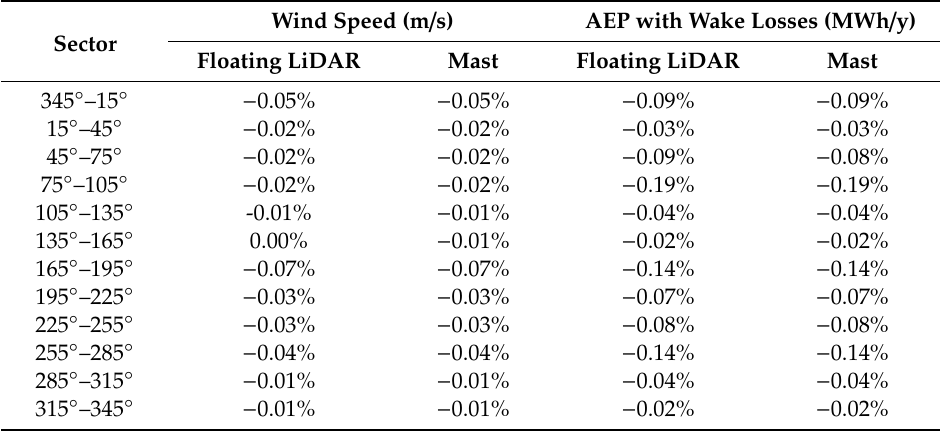
Table 10. E ff ects of wake loss on wind speed and AEP in various sectors determined using data from the floating LiDAR device and